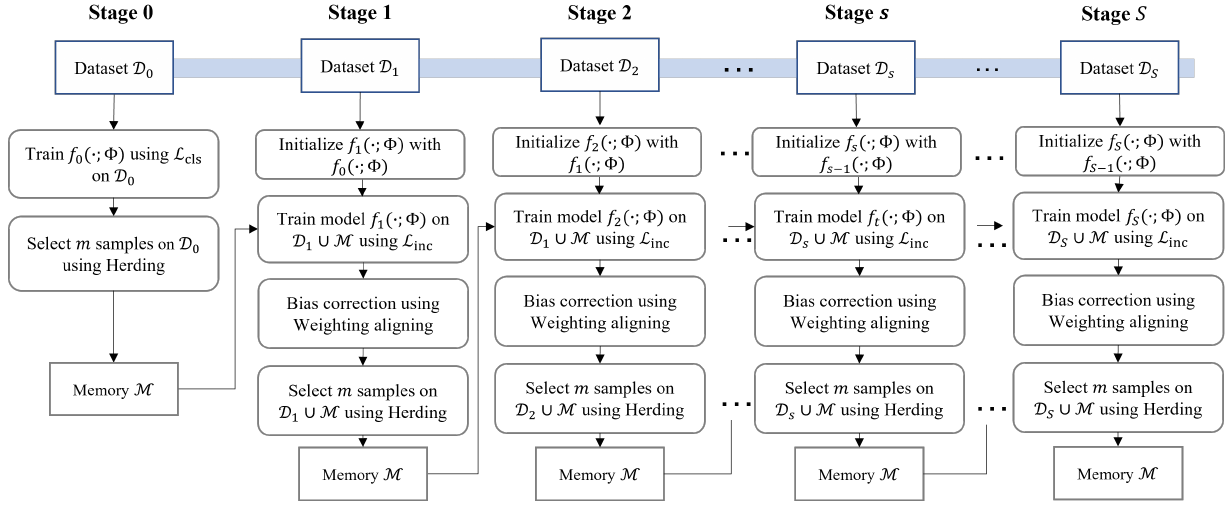
Figure 1. Flowchart of the proposed method throughout S incremental